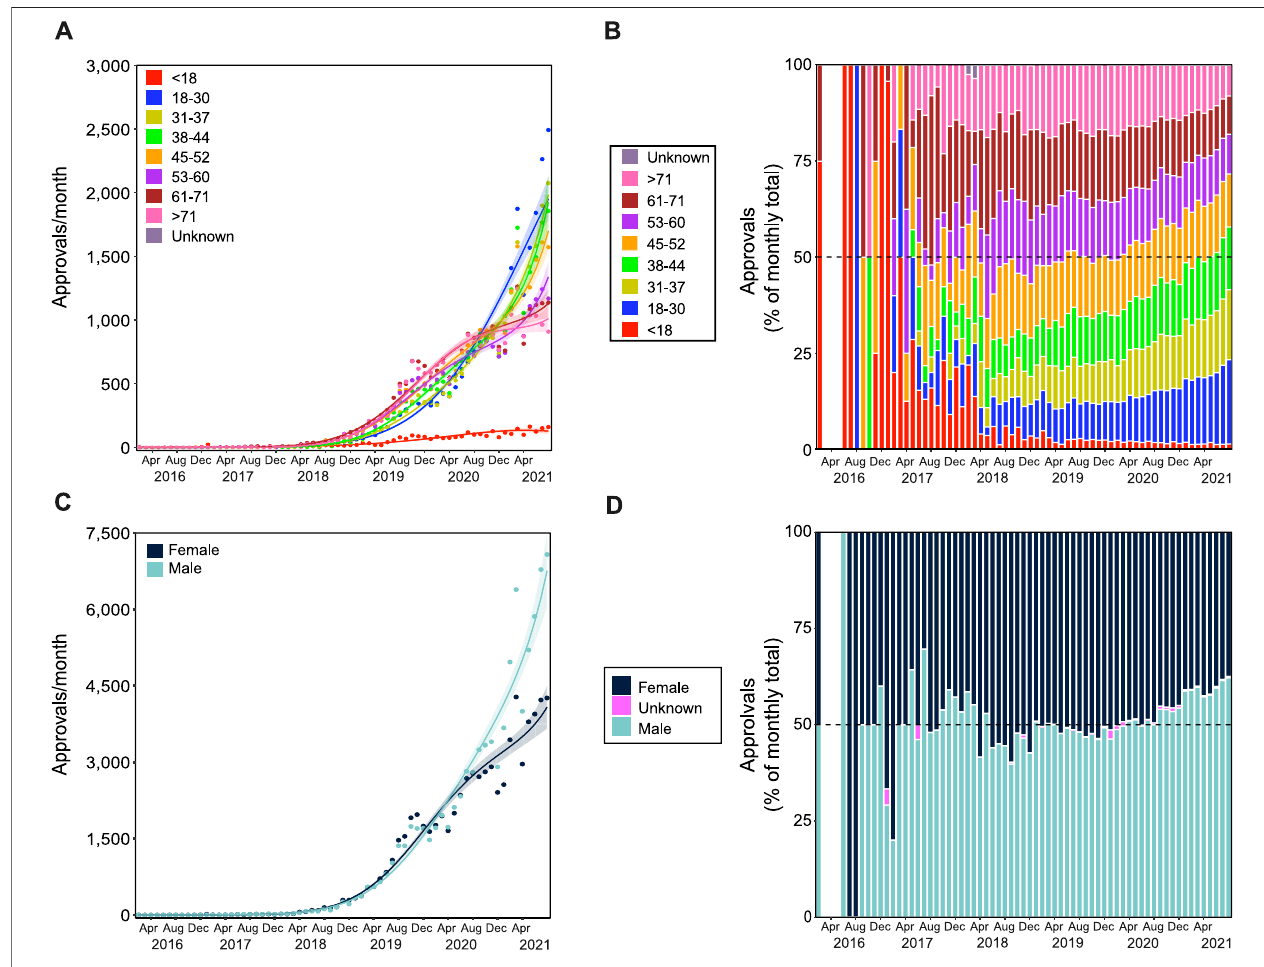
FIGURE 5 | Patient demographics for SAS-B approvals. Growth trends in age groups (A,B) and in patient genders (C,D) . Approvals for patients younger than 18 years and between 31 and 37 years of age followed a Negative binomial 3rd degree polynomial curve (R 2 = 0.888 and 0.993, and Δ m = 6.750 and 22.056, respectively); approvals for patients between 18 and 30 years of age followed a Negative binomial 2nd degree polynomial curve (R 2 = 0.986, and Δ m = 58.345); approvalsforpatientsinagegroups38to44,45to52,53to60,61to71,andover71yearsofagefollowedaNegativebinomial4thdegreepolynomialcurve(R 2 = 0.990, 0.990, 0.991, 0.985, and 0.989, and Δ m = 10.929, 16.765, 10.162, 27.937, and 8.374, respectively). Panel (B) shows the proportion of approvals for each age category(seelegend)permonth.ApprovalsforfemalesandmalesfollowedNegativebinomial4thdegreepolynomialcurves( C ;R 2 =0.986and0.989,and Δ m=32.522 and 16.797, respectively). The proportion (%) of approvals by patient gender per month are shown in panel (D) . Solid lines in panels (A) and (C) represent best fi t with shaded standard error of the mean. The gap (between February 2016 and June 2016 in panels (B) and (D) , indicates no applications submitted in this